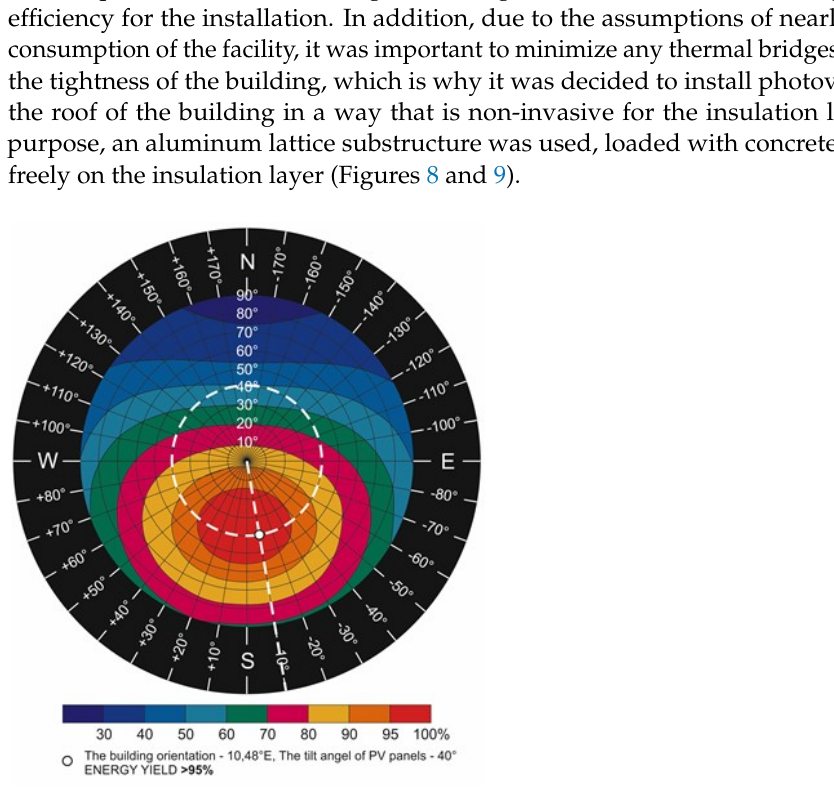
Figure 9. Photo of aluminum substructure on the roof. Finally, a photovoltaic cell installation was designed, consisting of 666 photovoltaic cells and generating a peak power of 199.8 kWp. These cells were connected with ten in- verters located in technical rooms on level 3 of the facility (Figure 10).